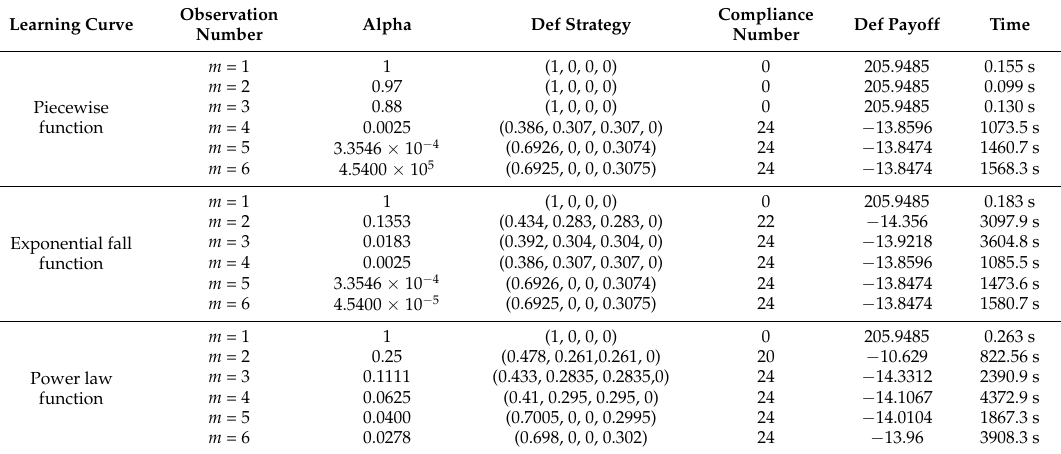
Table 4. Results of the extended chemical plant environmental protection (CPEP) game computed by COBRA under different observation conditions (the notation of time represents the running time of the solver and the notation of s in this table denotes